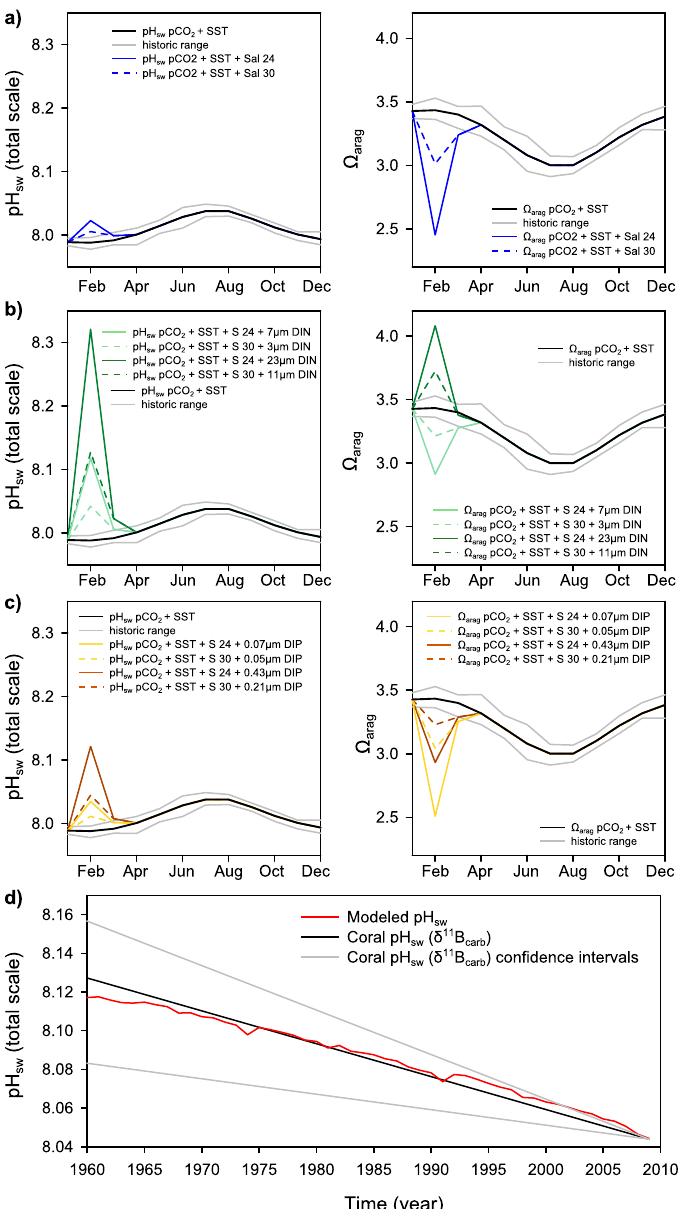
Figure 6. (a) Estimated seasonal pH sw and (cid:127) arag changes based on in situ SST (AIMS, 2011) with an average p CO 2 of 431ppm and a seasonal variation of 60ppm (Uthicke et al., 2014). Seawater pH values were estimated considering a seawater end member with summer total alkalinity (TA) of 2270mmolkgsw − 1 and winter TA of 2256mmolkgsw − 1 (Uthicke et al., 2014); dissolved inorganic carbon (DIC) changes were estimated from TA and p CO 2 . The grey lines define the range of historic maximum and minimum SST values for any given month. Shown here are changes in pH sw and (cid:127) arag resulting from a hypothetical flood event characterized by a decrease in salinity from 35 to values of 24 or 30 in February and increasing to 33 in March. For flood conditions the river water end member was estimated considering TA of 787.7mmolkgsw − 1 and DIC of 811.1mmolkgsw − 1 (DERM, 2014). (b) Estimated seasonal pH sw and (cid:127) arag changes as in (a) , including DIC changes associated with the CO 2 drawdown due to enhanced phytoplankton production during flood events based on DIN river inputs of 20 and 70µM in February and assuming conservative dilution. Nutrient inputs are estimated to reduce by half in March and back to seawater levels by April. (c) Estimated seasonal pH sw and (cid:127) arag changes as in (b) considering DIP river inputs of 0.15 and 1.3µM in February and assuming conservative dilution. (d) Estimated annual pH sw changes with time based on reconstructed SST (HadISST1), changes in atmospheric CO 2 (NOAA), and salinity changes associated with flood events obtained from the equation in Fig. S1. A comparison based on the average pH sw slope obtained from all the coral δ 11 B carb data in Table 2 is included. The minimum and maximum slopes obtained for the corals in Table 2 are included as confidence intervals. Calculations were made using CO 2 SYS with carbonate constants K1 and K2 from Merhbach et al. (1973) refitted by Dickson and Millero (1987), and for sulfate from Dickson (1990) with 0dbar